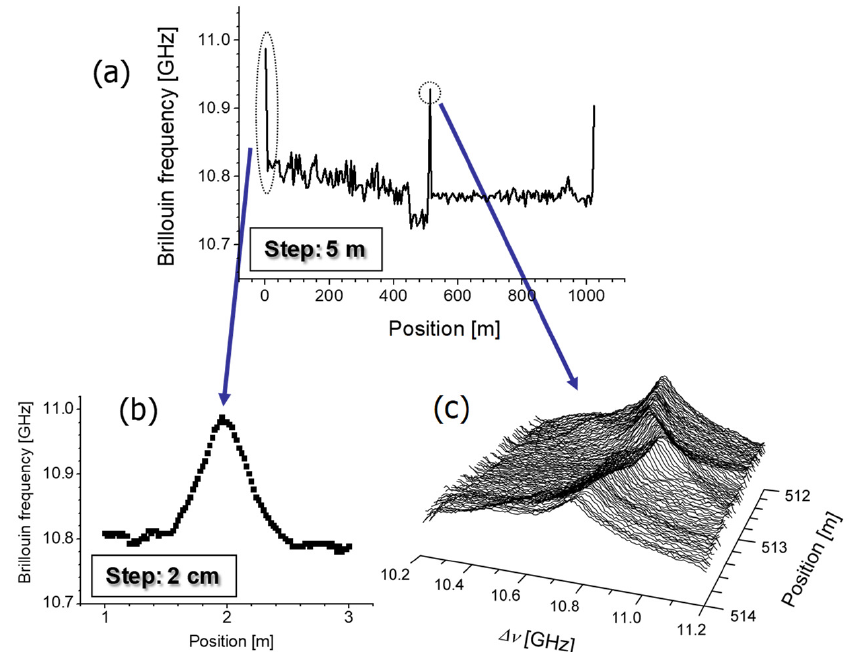
Figure 28. Experimental results of the distributed measurement by the BOCDA system shown in Figure 27. ( a ) Total distribution of the BFS; the spatial resolution is set to be seven cm, and the measurement range is elongated by the temporal gating scheme to be 1030 m. The ratio between the range and the resolution is 14,570; ( b ) BFS distribution at a strain-applied portion. ( c ) BGS distribution at another strain-applied portion [54].